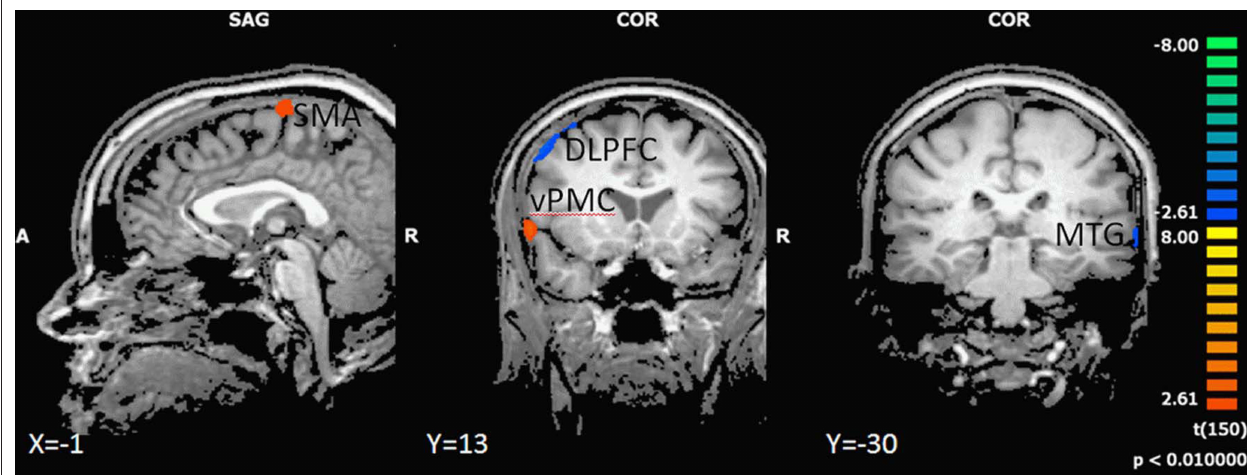
FIguRe 4 | effect of motor status on brain activation during imagery of backward walking. Regions with significant differences for high and low motor fit participants are shown in blue to green (low fit > high fit) and orange to yellow (high